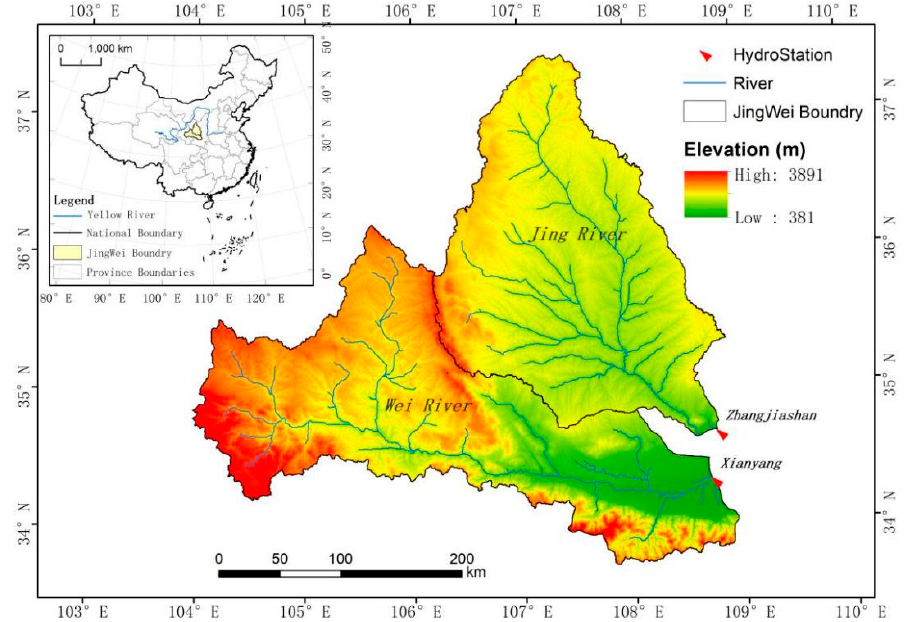
Figure 1. Location of the study area and distribution of the hydrostations in the Wei and Jing River Basin.